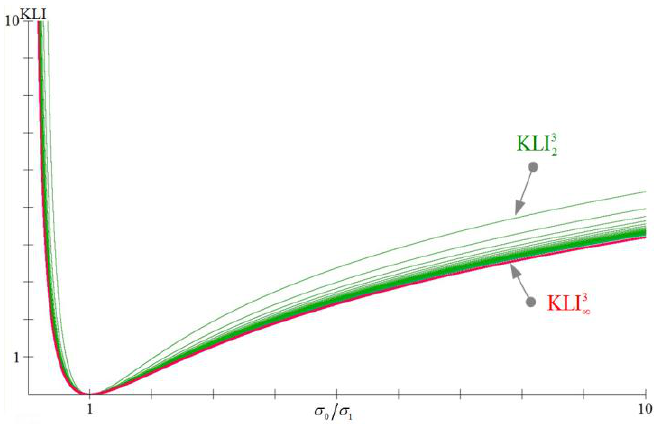
, as functions of 